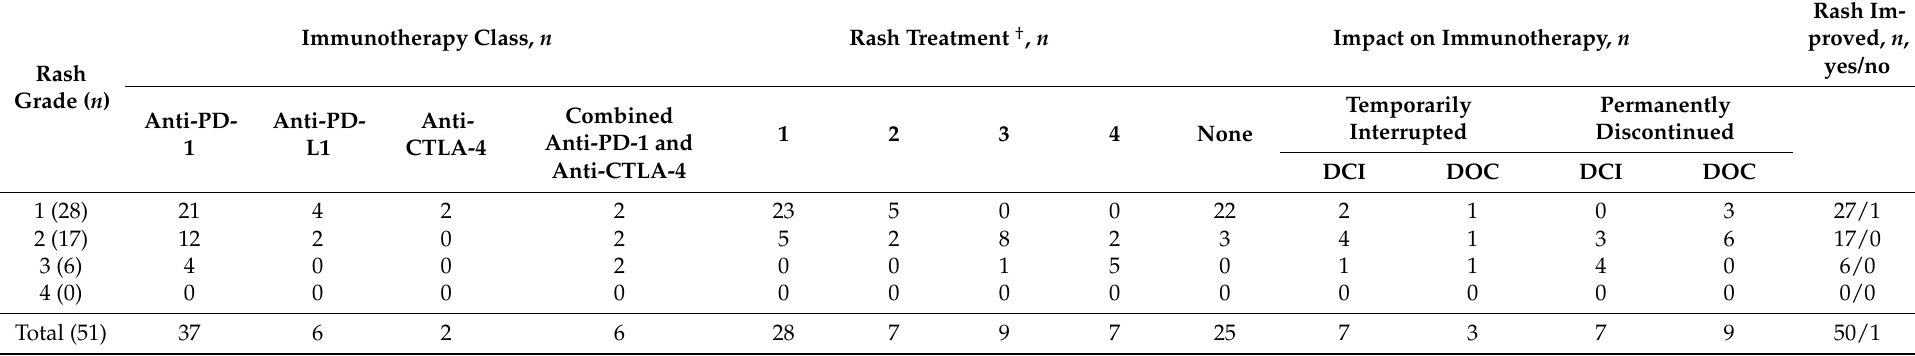
Table 4. ICI therapy class, rash treatment, impact on immunotherapy, and therapeutic response according to the rash